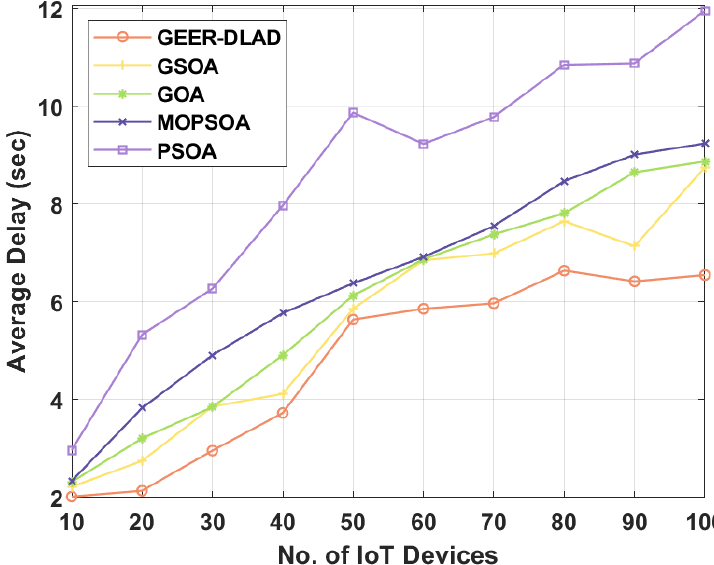
Figure 8. Average delay analysis of GEER-DLAD model.